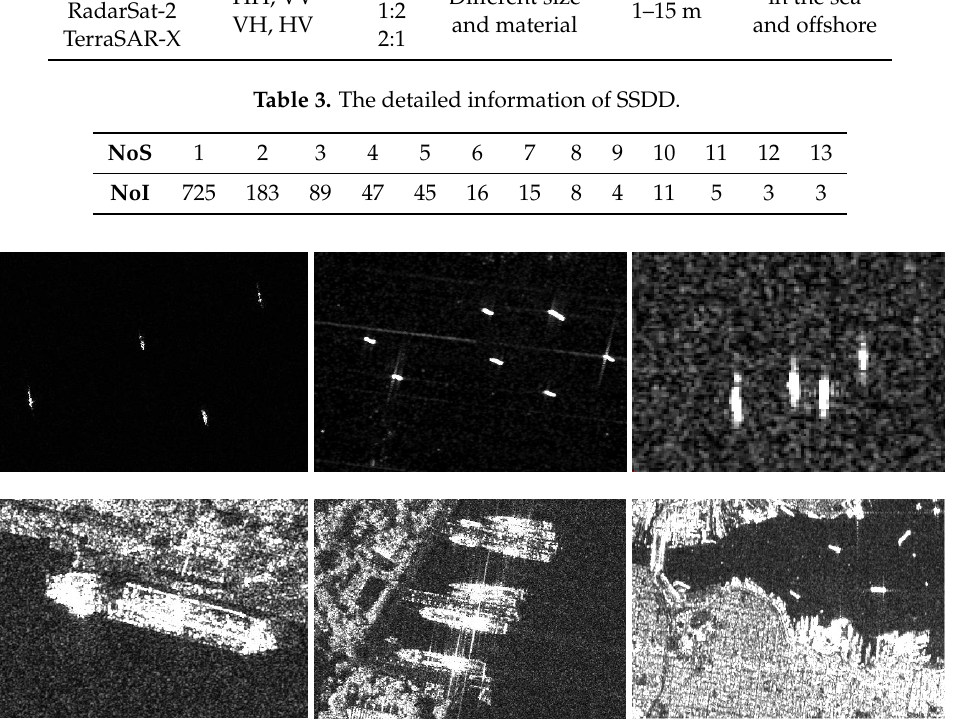
Figure 9. Samples from synthetic aperture radar (SAR) ship detection dataset (SSDD). The first line has ships in the open sea, the second line has ships near the dock and